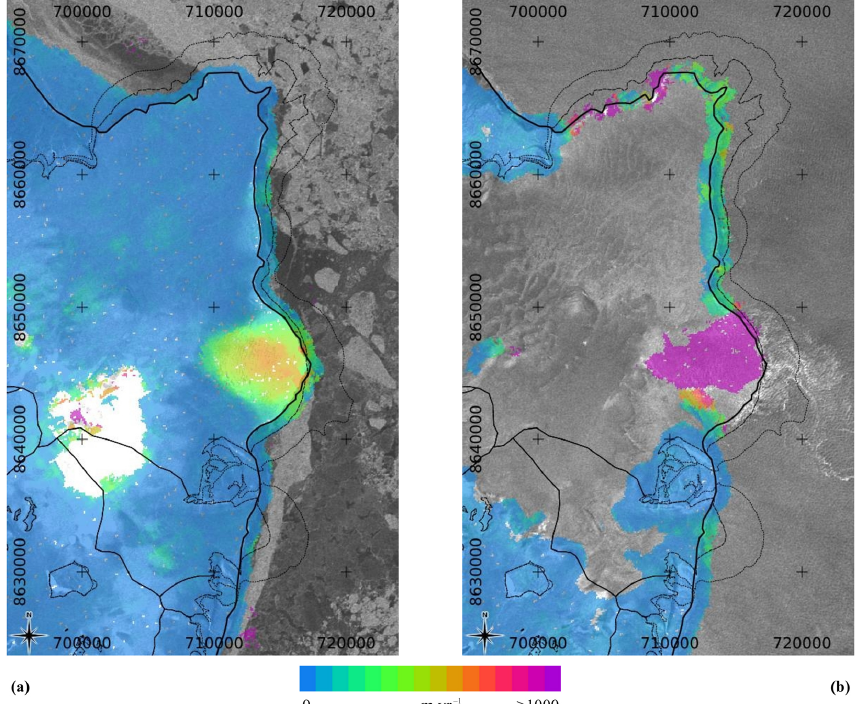
Figure 7. Ice surface velocity maps from (a) Sentinel-1 data of 21 January 2015 and 2 February 2015 and (b) Sentinel-1 data of 30 Septem- ber 2015 and 12 October 2015. Image background is a backscattering intensity image of the respective first scene used for offset tracking. The coastal outline in 2015 (continuous line) is shown along with glaciers inventories of 1971 (dotted line) and 2006–2007 (RGI 5.0, dashed